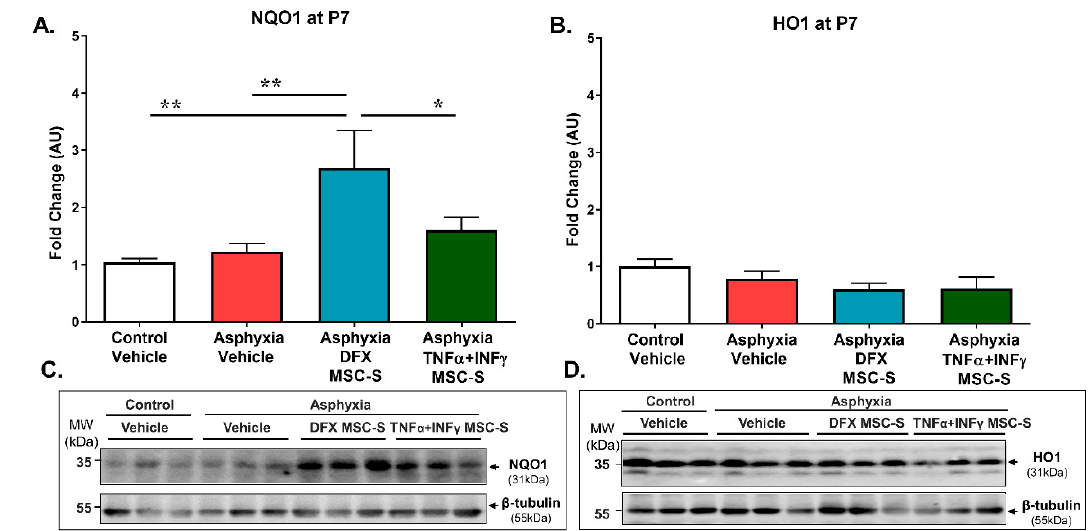
Figure 3. E ff ect of intranasal administration of DFX- or TNF- α + IFN- γ -MSC-S on NRF2 e ff ector NQO1 and HO1 protein levels determined in hippocampus of PA-exposed and control rats at P7. ( A ) NQO1 and ( B ). HO1 hippocampal protein levels evaluated by Western blot in control (CS, white bar) and asphyxia-exposed rats (AS, red bar), intranasally treated with vehicle- or DFX -MSC-S(cyan bar) or TNF- α + IFN- γ -MSC-S (green bar) at P7. β -tubulin was used as normalizer for protein extracts. Data are presented as ratios of protein levels / normalizer levels, relative to vehicle control levels. Representative Western blot images are shown in ( C ) and ( D ). Data represent means ± SEM. ( A ) NQO1levels: A single intranasal administration of DFX-MSC-S to PA-exposed rats (cyan bar) increased NQO1 levels compared to AS (red bar) and CS rats (white bar). One-way ANOVA, F (3,19) = 4.966,* p < 0.01 Benjamini, Hochberg, and Yekutieli post-hoc: ** p < 0.005, CS v / s Asphyxia-DFX-MSC-S, ** p < 0.005; AS v / s Asphyxia-DFX-MSC-S, * p = 0.05; Asphyxia-DFX-MSC-S v / s Asphyxia-TNF α + IFN- γ -MSC-S, N = 5–6 samples per group. ( B ) HO1 levels: No e ff ect of PA and / or MSC-S treatment was observed on HO1 protein levels, evaluated in hippocampus at P7. One-way ANOVA, F (3,29 = 1.726, n.s. N = 8 samples per group.